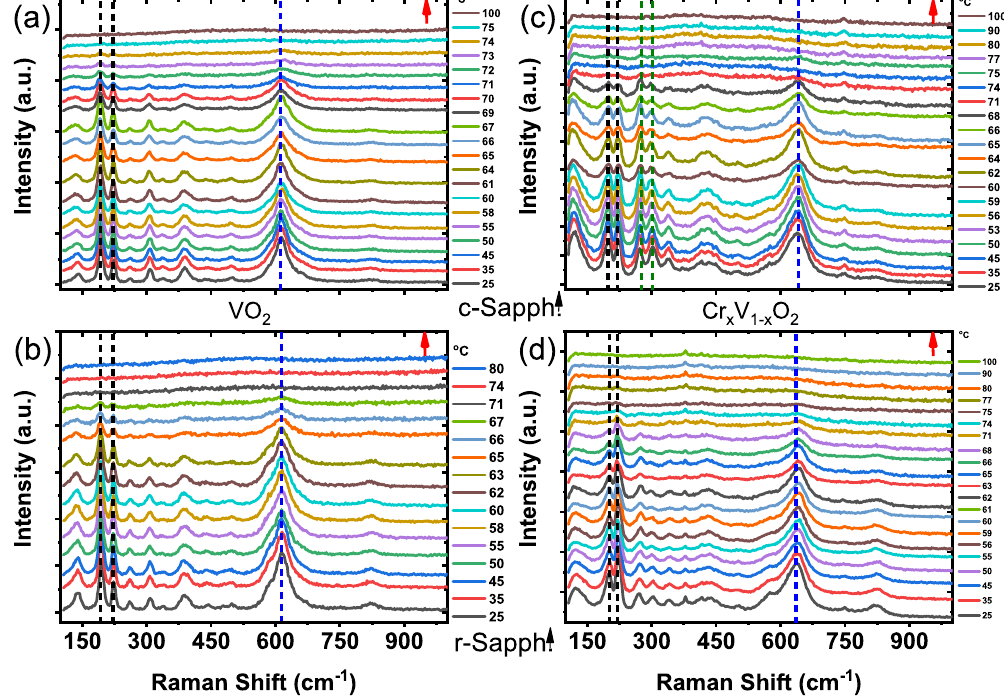
Figure 6. Raman spectra of undoped ( a , b ) and Cr-doped ( c , d ) VO 2 on c-plane and r-plane sapphire substrates with the red arrows indicating the thermal cycle of heating. The dotted black and blue lines depict the Raman peak positions of the low (V–V) and the high (V–O) frequency Raman modes respectively.